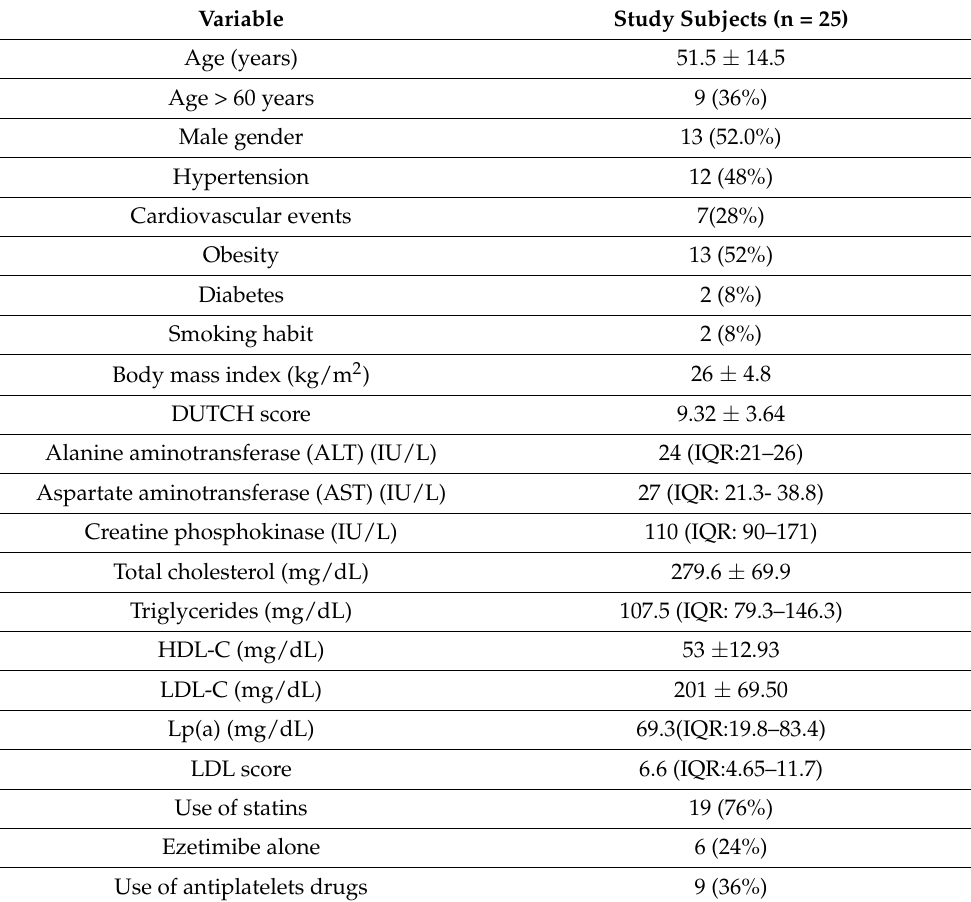
Table 1. Demographic and baseline characteristics of the FH study population before treatment with PCSK9